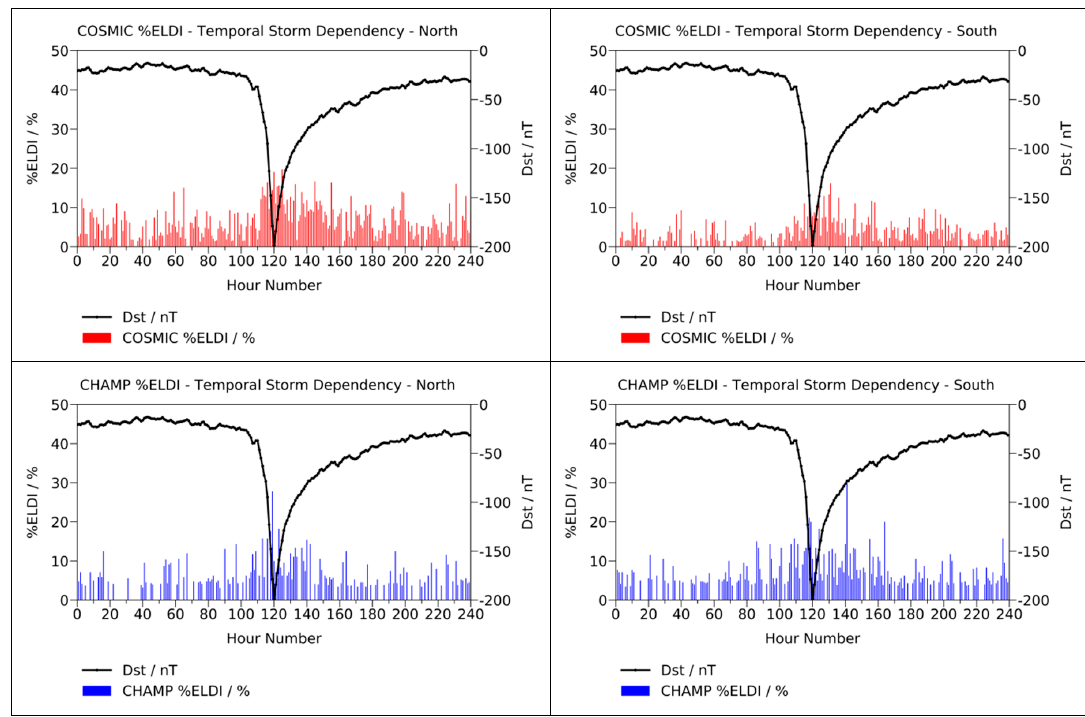
Figure 9. Temporal variation of %ELDI during geomagnetic storms. ( Top panels ) COSMIC; ( bottom panels ) CHAMP, ( left panels ) northern high latitude region; ( right panels ) southern high latitude region.